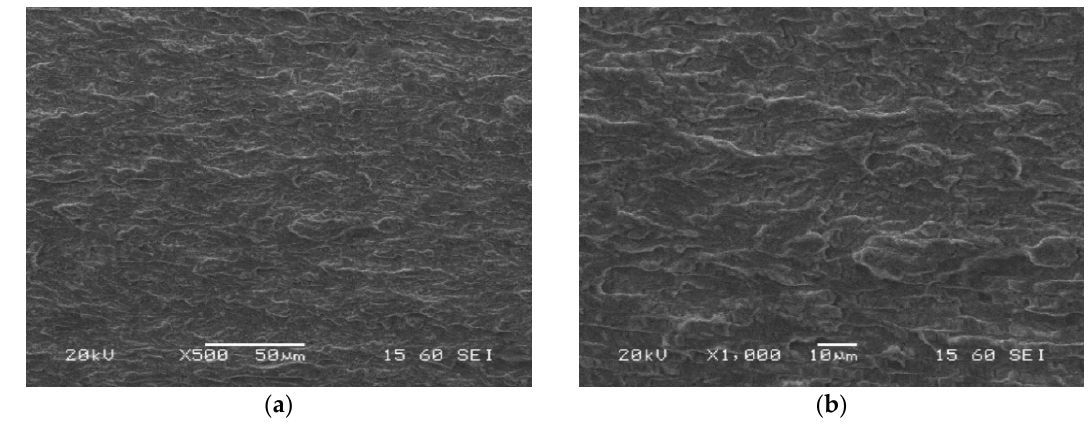
Figure 18. Microstructures of the fatigue pre-crack zone of the HAZ (specimen No. 6) captured after CTOD test using SEM; magnifications: ( a ) ×500; ( b ) ×1000.